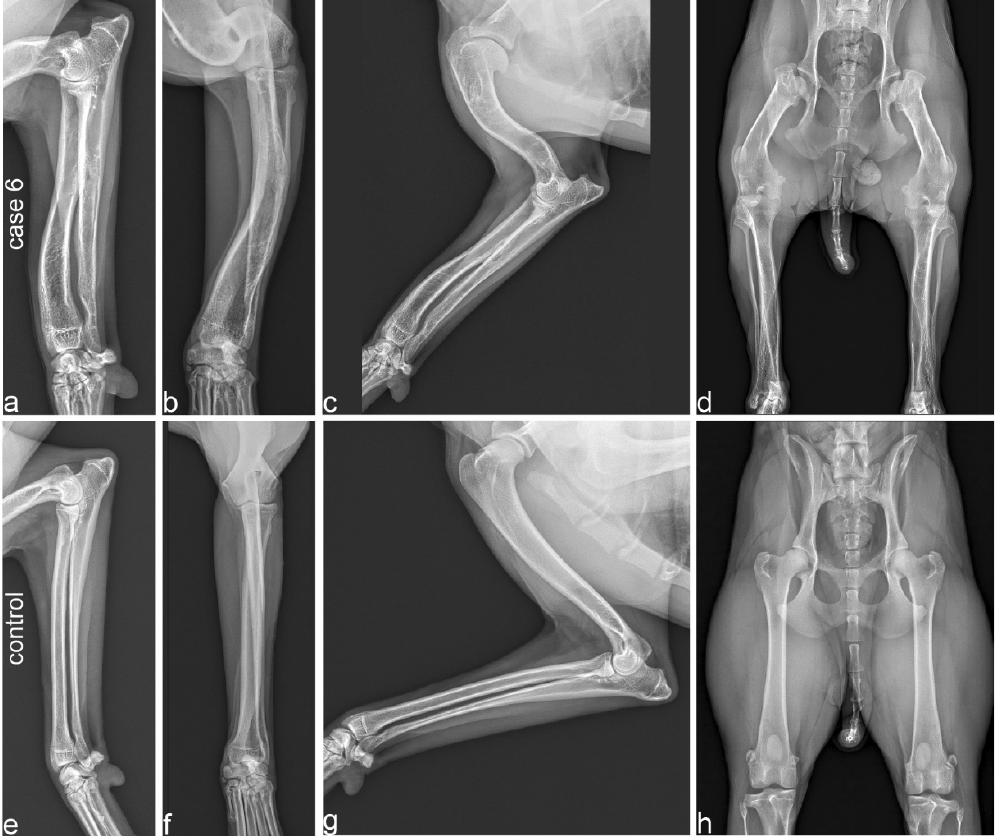
Figure 3. Radiographs of a 2-year-old affected Vizsla (case 6; a–d ) and its 3-year-old unaffected half-sister ( e–h ). ( a , b ) Orthogonal radiographs of the radius and ulna in case 6 show procurvatum and varus deformity, and thick and short bones. ( c ) Humerus and antebrachium of the affected Vizsla. Note the marked deformity and shortening of the humerus, flattened articular surface and deformity of the humerus. ( d ) Extended hip radiograph of the affected dog. Note the marked shortening and deformity of the femur, including its epiphysis, resulting in subluxation of the hip joint and secondary deformity of the acetabula. ( e , f ) Orthogonal radiographs of the radius and ulna. All long bones of the unaffected control dog demonstrate a normal limb axis and normal relation between the length and thickness of the bones. ( g ) Humerus and antebrachium of the unaffected control. ( h ) Extended hip radiograph of the unaffected dog. Please note that the scale of the radiographs is not standardized.